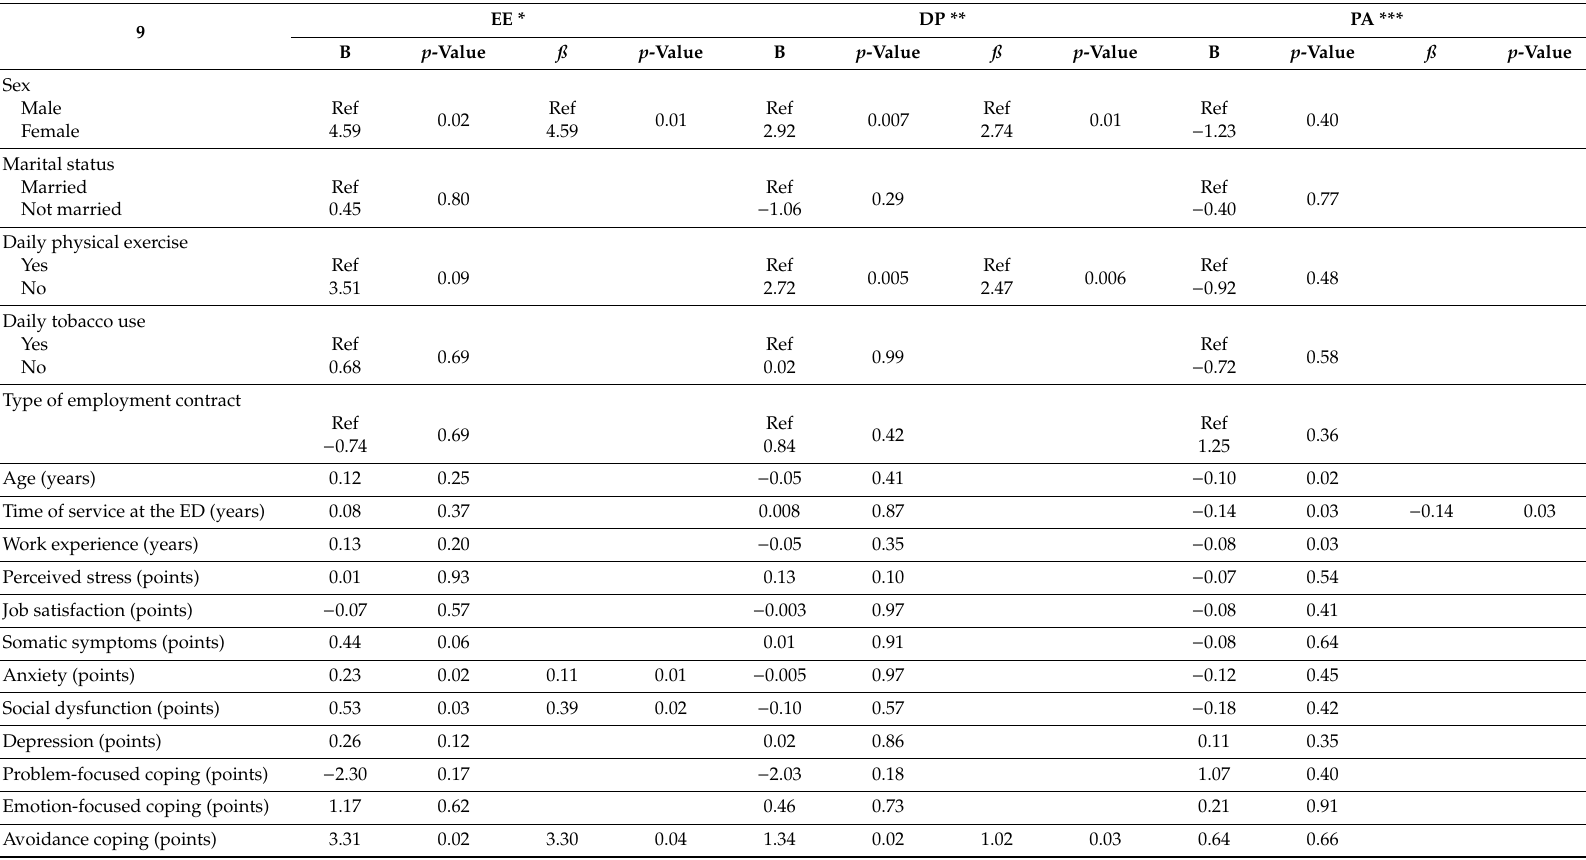
Table 4. Multivariate analysis for the variables predicting each dimension of